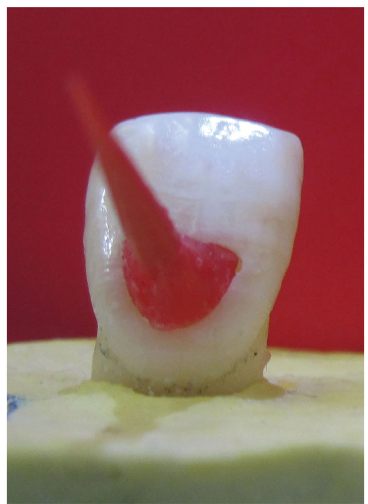
Figure 2: Resin template for guiding the cavity preparation.